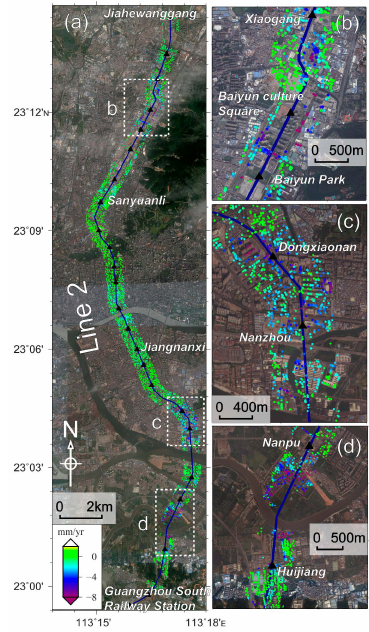
Figure 4. ( a ) PALSAR deformation rate map of Line Two. Regions b, c, and d, marked by white dashed rectangles, are the three subsiding areas along Line Two, and their enlarged figures are shown in ( b ), ( c ), and ( d ), respectively.